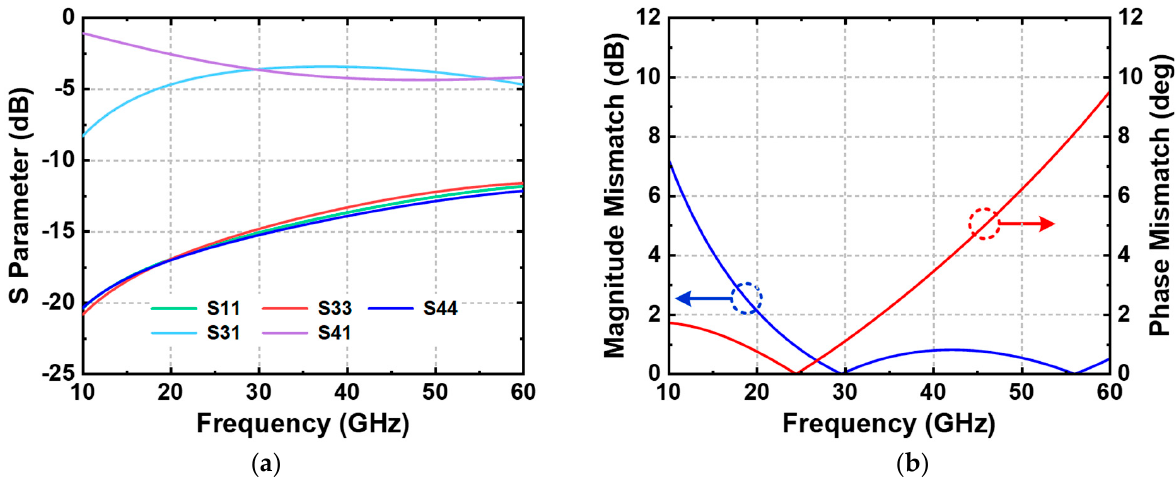
Figure 6. ( a ) Simulated S-parameters of the proposed transformer-based quadrature hybrid. ( b ) Magnitude (blue line) and phase (red line) mismatch of the proposed transformer-based quadrature hybrid.